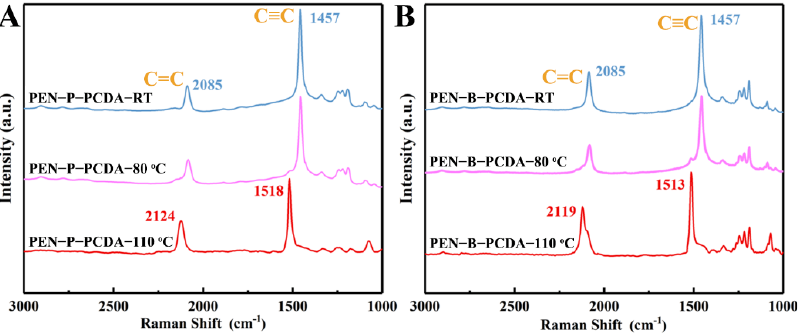
Figure 5. Raman spectra of PEN − P − PCDA ( A ) and PEN − B − PCDA ( B ) before and after exposure to different high temperatures (80 °C and 110 °C).